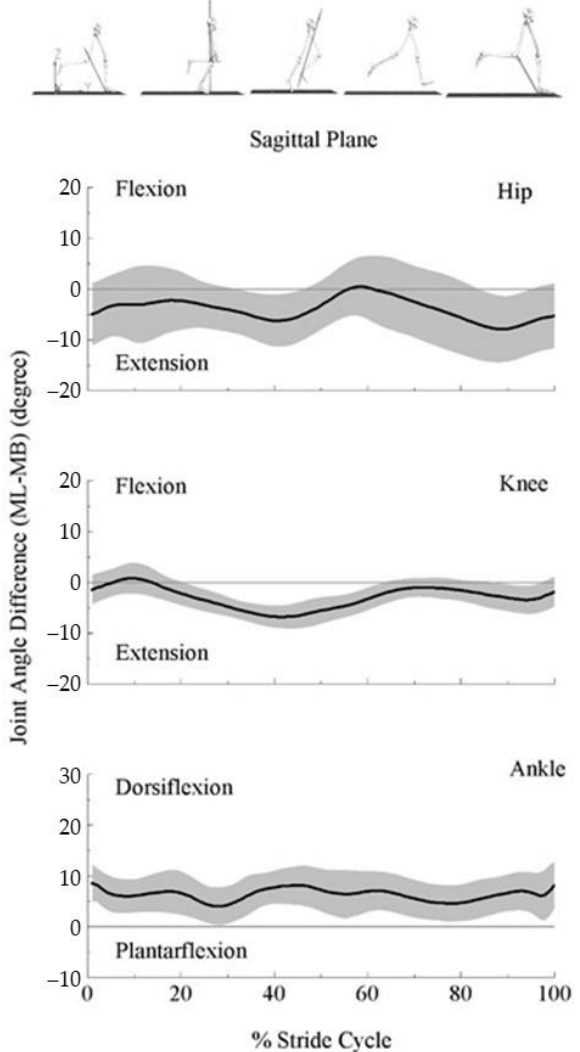
Figure 5. Ensemble curve of lower extremity joint angle differences in the sagittal plane between marker-based (MB) and markerless (ML) motion capture systems across the average 10 stride cycles for 16 participants. Differences were estimated as ML joint angles of each joint—MB joint angles of each joint.